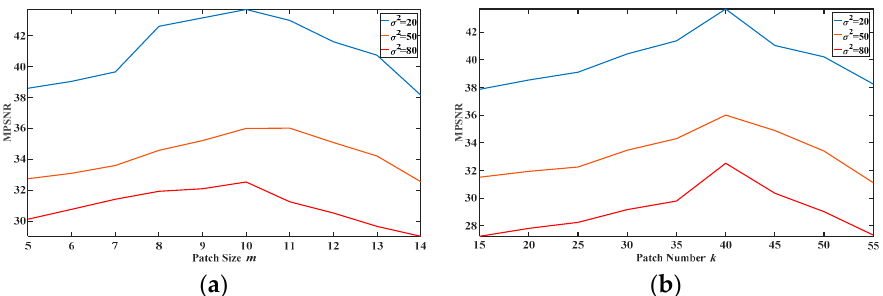
Figure 12. PSNR value changes: ( a ) mean peak signal-to-noise ratio (MPSNR) versus patch size (m) and ( b ) MPSNR versus patch number (k).